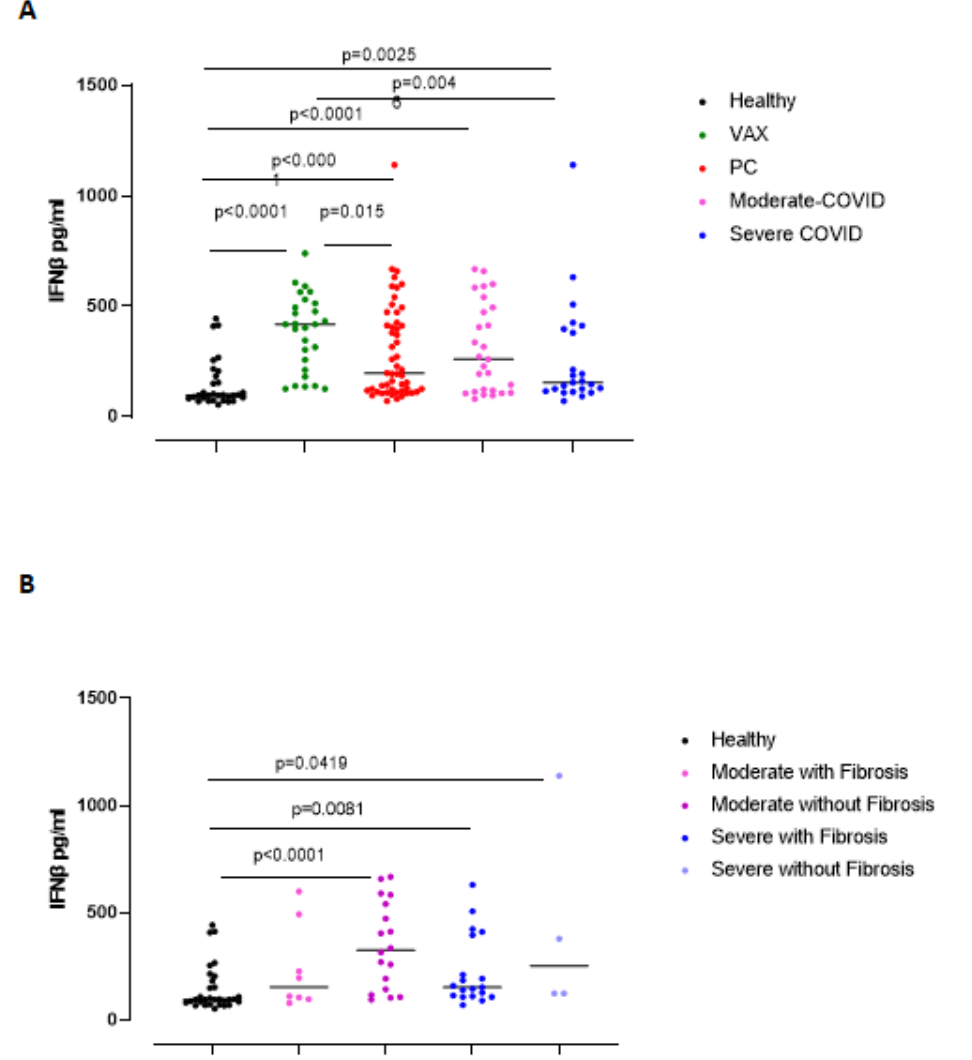
Figure 3. Plasma levels of IFN- β were increased in PC patients but reduced according to the presence of symptoms and signs of lung fibrosis. ( A ) Circulating levels of IFN- β were higher in vaccinated (VAX) subjects than in healthy and PC patients (green vs . black and red dots); these levels did not discriminate moderate (pink dots) vs . severe (blue dots) PC patients. Instead, ( B ) the absence of fibrosis in PC patients was characterized by higher levels of IFN- β in moderate (purple dots) and severe (bright blue dots) PC patients. Data are expressed as median. Statistical analysis was performed according to the Mann–Whitney U test.